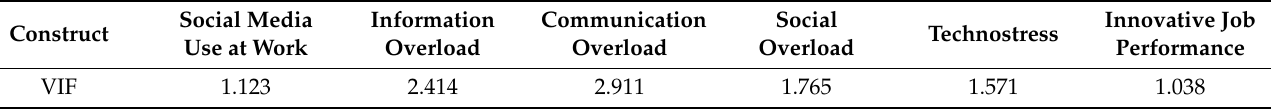
Table 4. Full Collinearity.